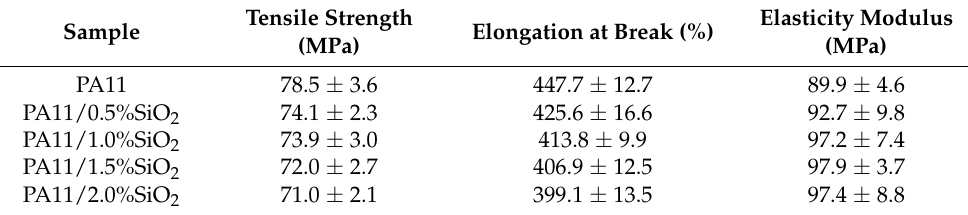
Figure 9. ( a ) Storage modulus, ( b ) loss modulus, and ( c ) tan δ of neat PA11 along with PA11/SiO 2 composites.